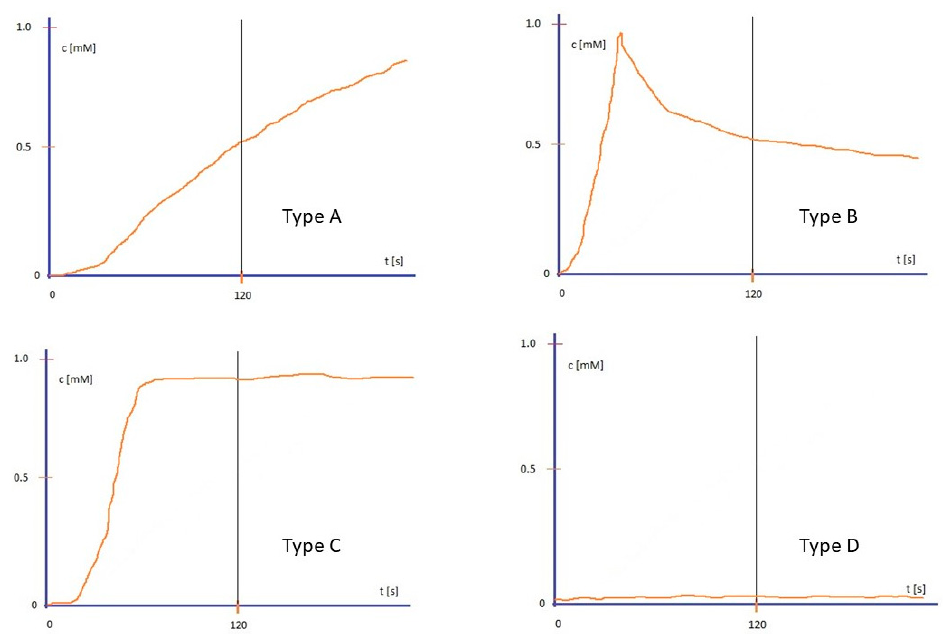
Figure 8. Time/intensity curves of dynamic contrast-enhanced perfusion weighted imaging. Expla- nations in the text. c: concentration of contrast agent expressed in millimoles (mM). t: time (seconds).